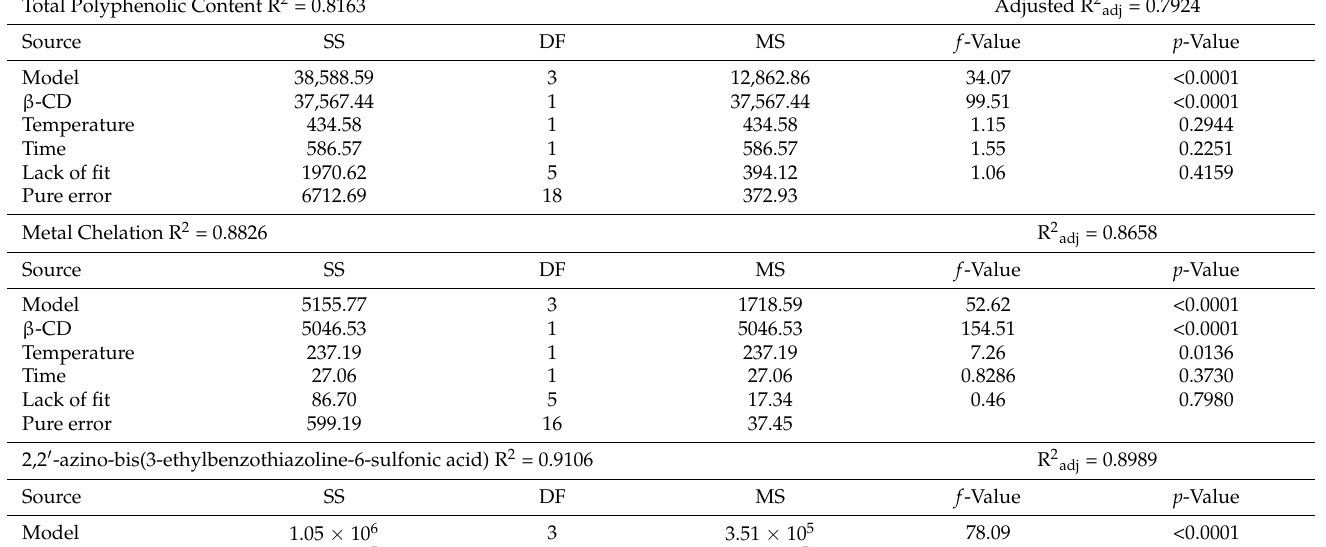
Table 2. ANOVA used regression coefficients to model the effects of variables ( β -CD concentra- tion, temperature and time) on the total phenolic content and antioxidant activity of crude green rooibos